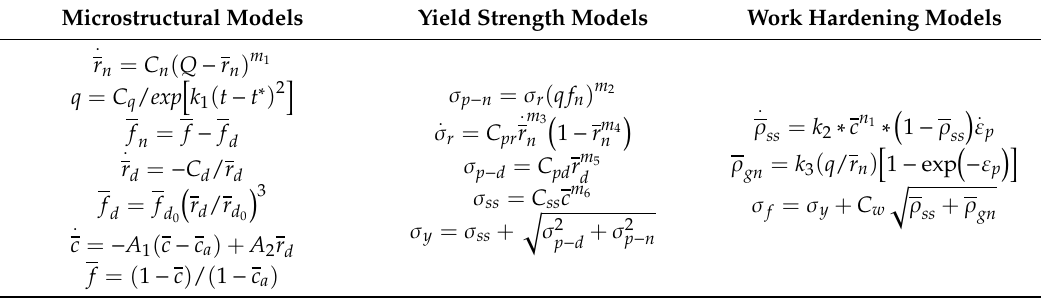
Table 2. Summary of the constitutive model for ageing of AA6063. Microstructural